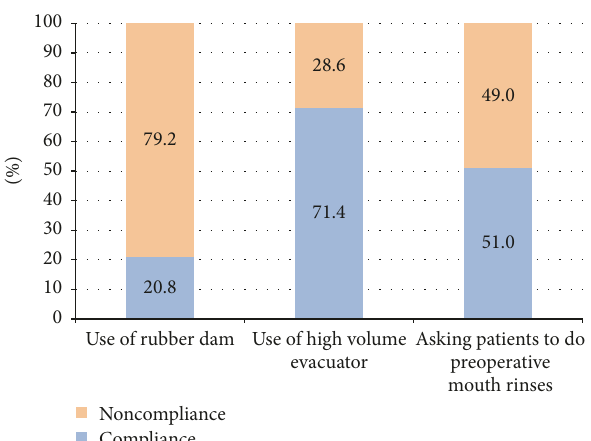
Figure 2: Graph showing compliance with aerosol control in Lebanese private dental clinics